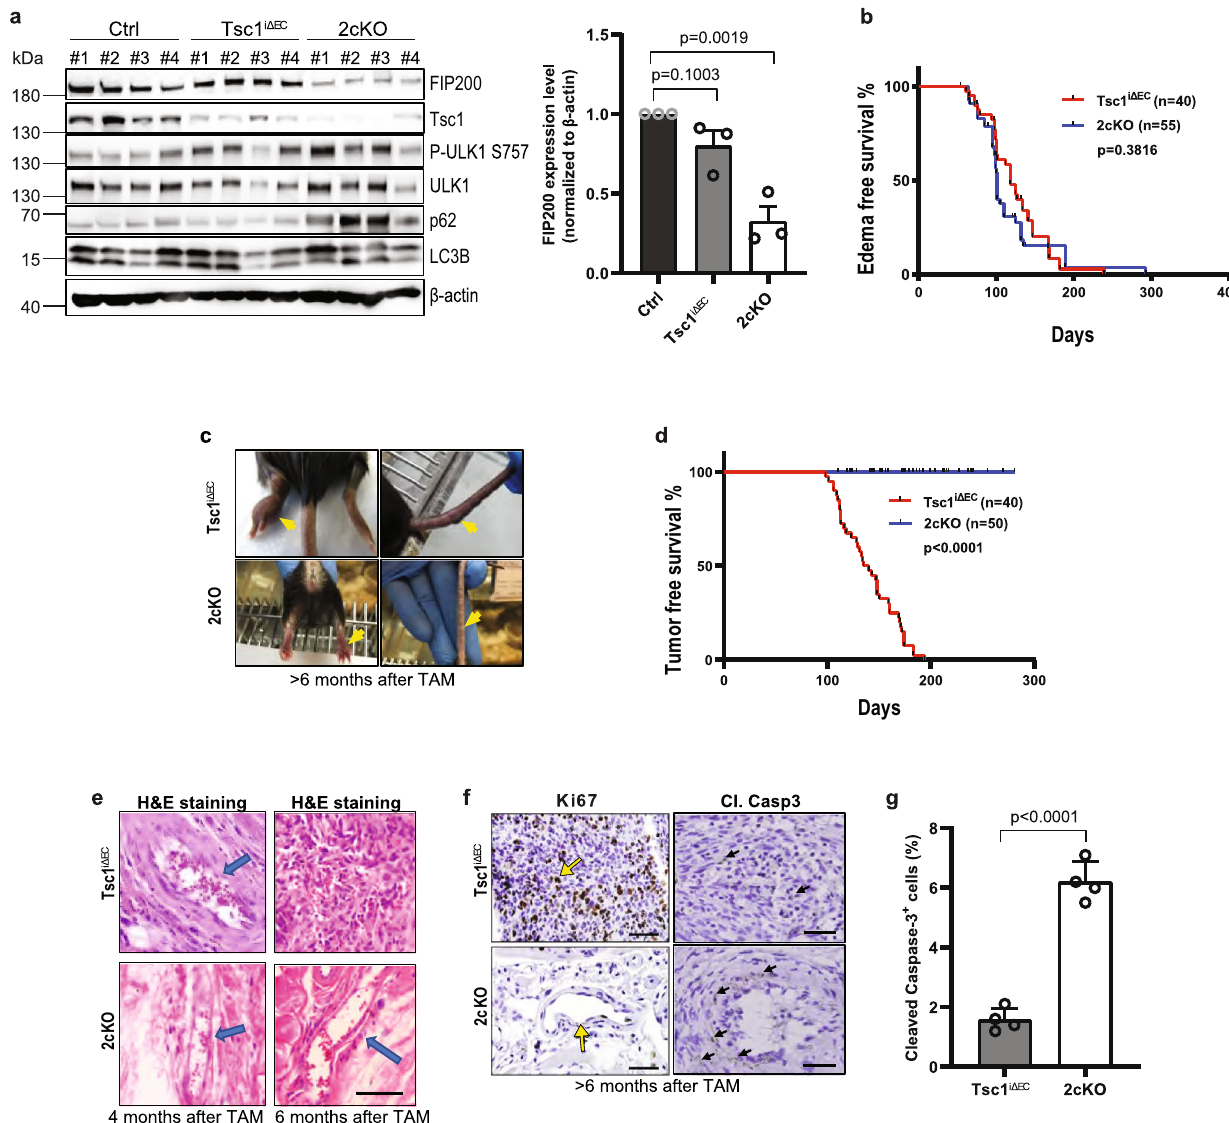
Fig.1| Fip200 ablationblocksLMprogressiontoLAS.a LysatesfromlungECsof wild type (Ctrl), Tsc1 i Δ EC mice and 2cKO mice (4 each) were analyzed by western blots for Tsc1, Fip200, p62, P-ULK1 S757, ULK1, LC3B and β -actin. Relative levels of Fip200/ β -actinratios(normalizedtoCtrlcells)areshownasmean±SDontheright. n =3independentexperiments. b Kaplan-Meieranalysisofedemadevelopmentfor Tsc1 i Δ EC ( n =40) and 2cKO ( n =55) mice. Log-rank (Mantel – Cox) test, p =0.3816. c Representative images of tail and paw of Tsc1 i Δ EC mice with tumours and 2cKO micewithedema.Arrowsmarktumors( Tsc1 i Δ EC )andlesions(2cKO). d Kaplan-Meier analysisofLAS for Tsc1 i Δ EC ( n =40) and 2cKO ( n =50) mice. Log-rank (Mantel – Cox)